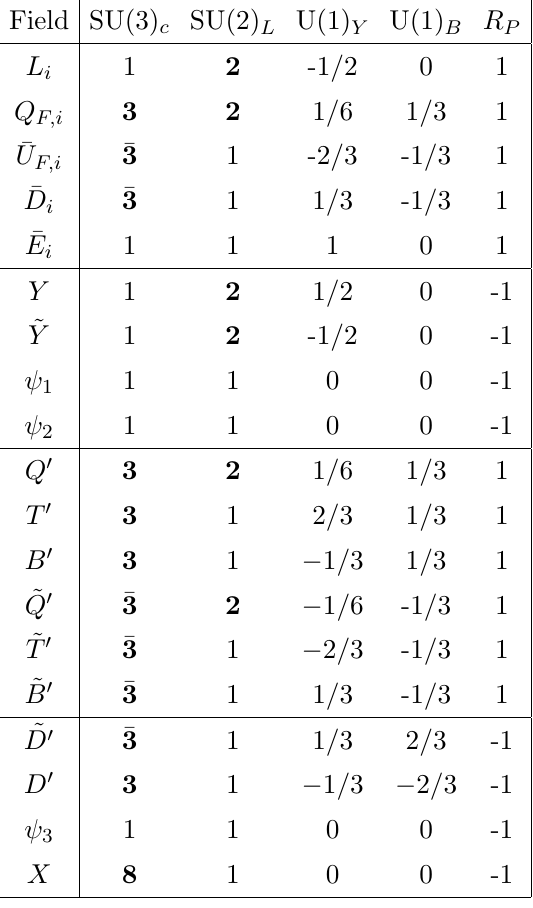
Table 4 . Spin-1/2 (cid:12)eld content of the low-energy e(cid:11)ective theory. All (cid:12)elds are left-handed 2 component Weyl